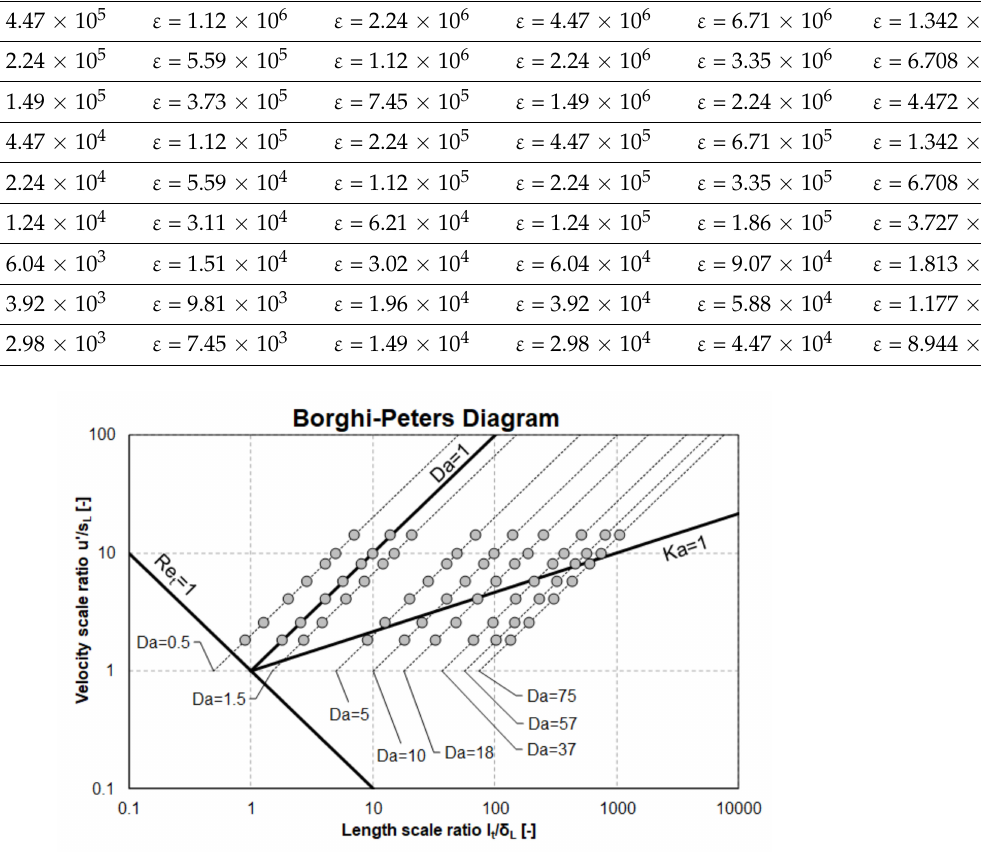
Figure 4. Borghi–Peters diagram for turbulent combustion regimes with the set of tested conditions using the test case (grey